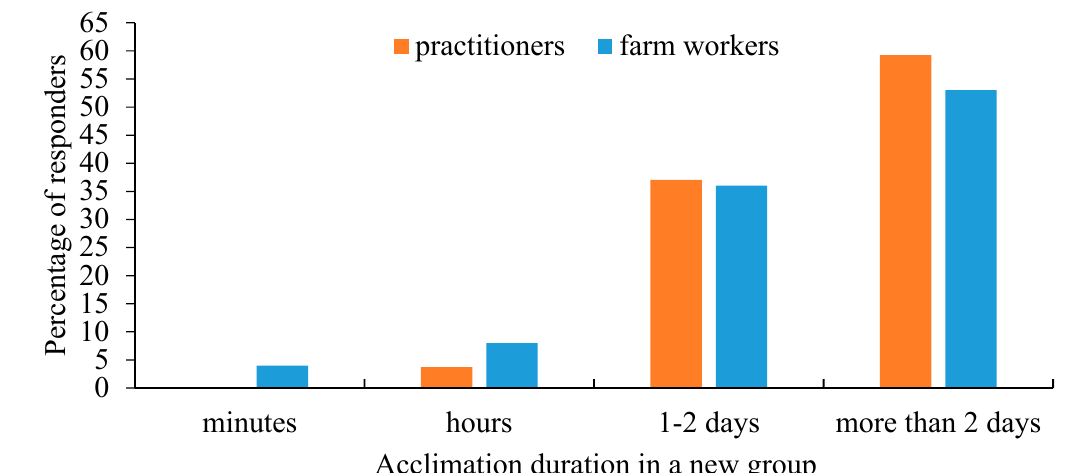
Figure 7. The distribution of the farm workers’ ( n = 478) and practitioners’ ( n = 27) assessment of required acclimation duration in a new group of unfamiliar cows. There were no statistical differences among groups.